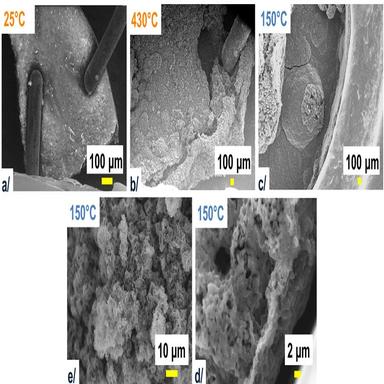
a/−c/ Highlight on the LiOH melting during the heating step and after cooling at a partial pressure of 10 Pa. e/−d/ Zoom in on the sample at the edge of the crucible.